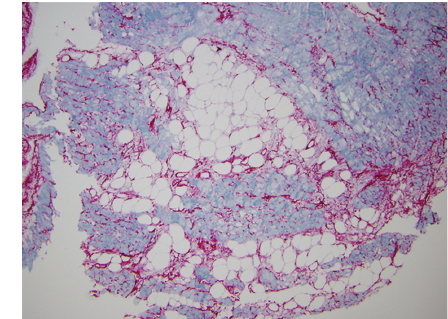
Figure 2: Endomyocardial biopsy.